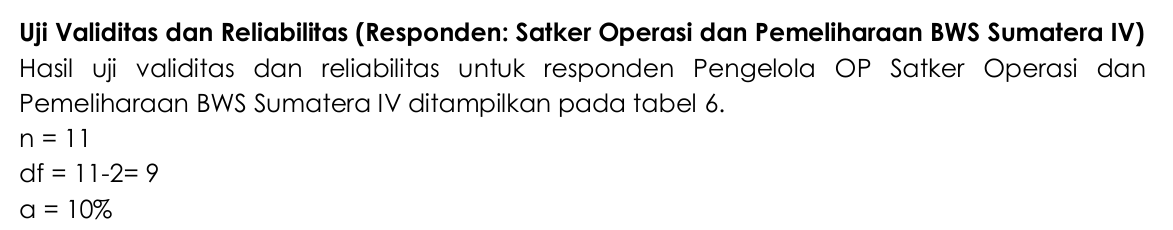
Tabel 6 menunjukkan bahwa item-item tersebut valid dan reliabel. Sehingga kuesioner pada penelitian ini dinyatakan valid dan konsisten ( reliable